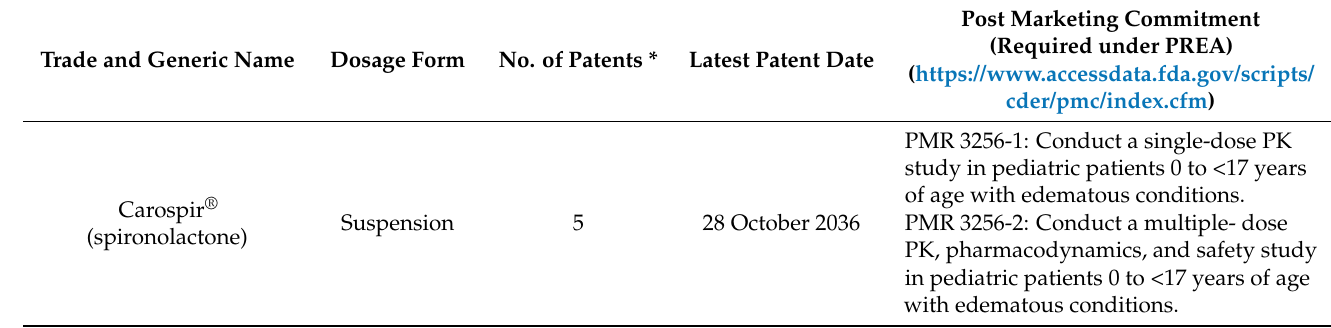
Table 3. Examples of Patents and Post Marketing Commitments for Recent US-FDA Approved Pediatric Dosage Forms via the NDA Pathway